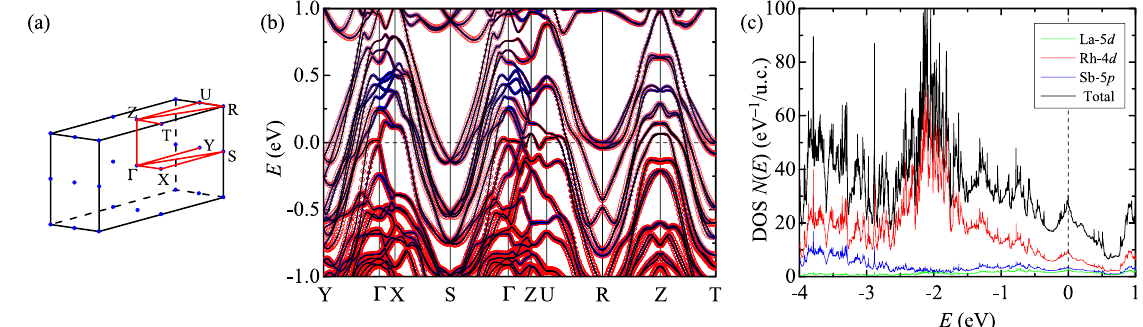
Figure 7. First-principles electronic structure of La 2 Rh 3 Sb 4 . (a) Sketch of Brillouin zone. (b) Band structure where the size of the red and blue circles represent the weight of Rh-4 d and Sb-5 p orbitals, respectively. (c) Enlarged band structure along Y- Γ -Z paths to show the semi-flat feature near Γ . (d) Density of states. For pristine La 2 Rh 3 Sb 4 , Fermi level likely sits at a van-Hove singularity where N ( E )